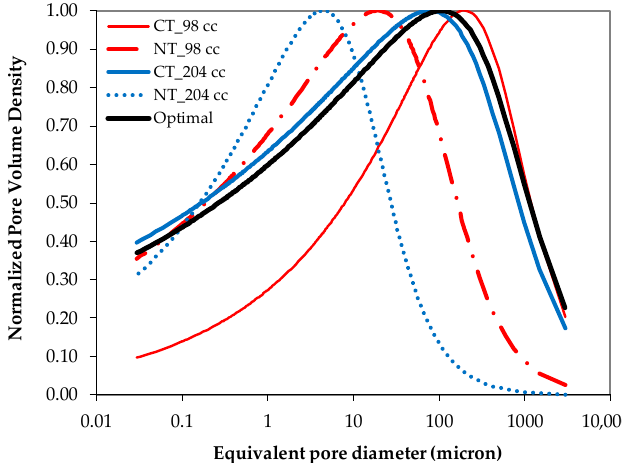
Figure 8. Normalized pore volume distribution functions of the two sample volume–soil management combinations for the Foggia site, compared with the reference curve (optimal) proposed by Reynolds et al. [2].